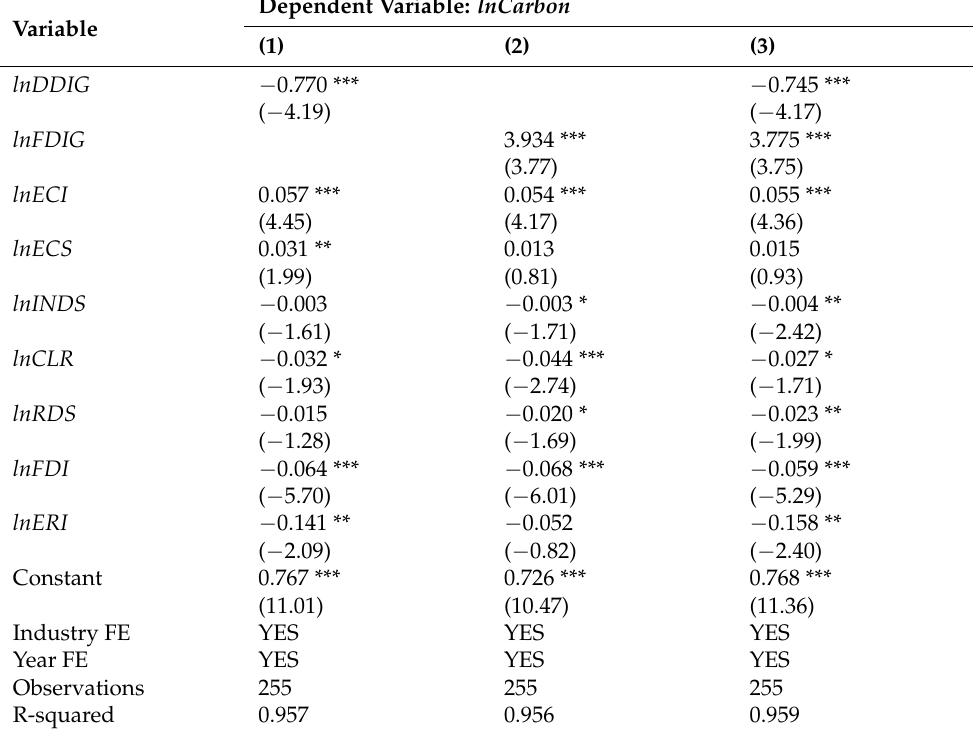
Table 10. Complementary analysis